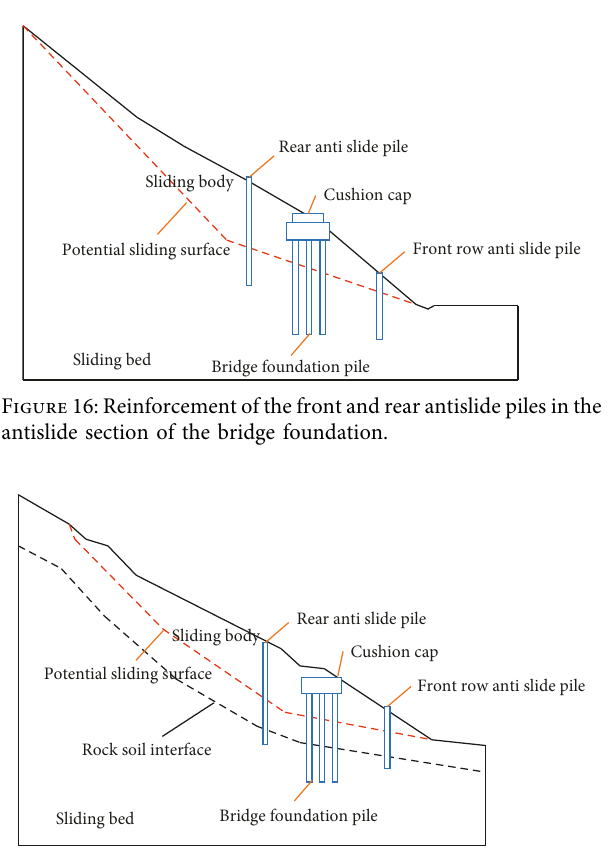
Figure 17: Reinforcement of the front and back row antislide piles in the sliding section of the bridge